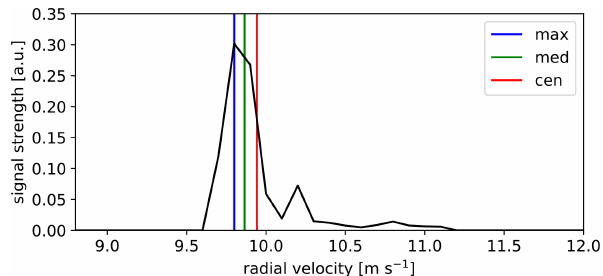
Figure 1. Example of a Doppler radial velocity spectrum simulated in a turbulence box, including the radial velocity estimates using the maximum (max), the median (med) and the centroid (cen)